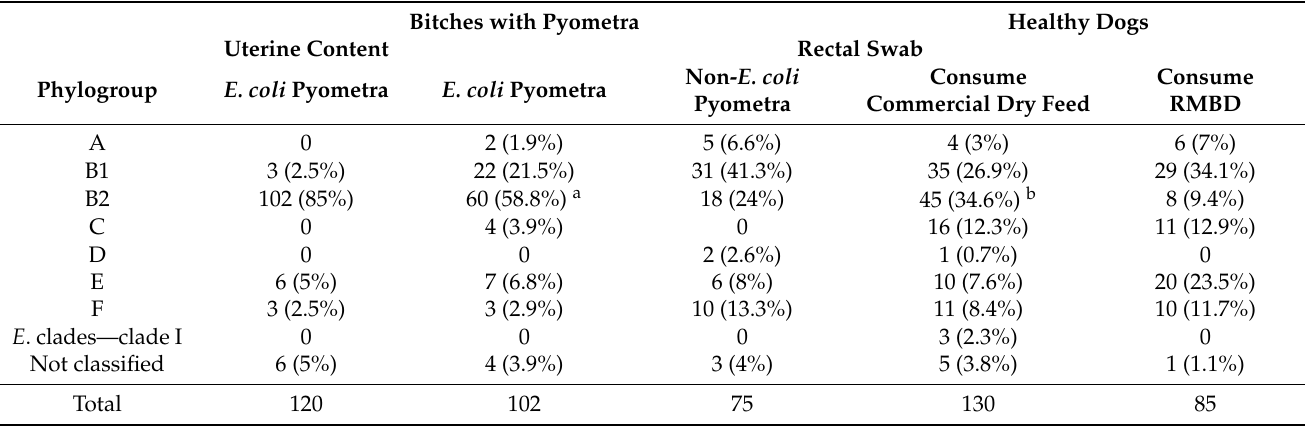
Table 2. Number of isolates and frequency of E. coli phylogroups identified in the uterine content, rectal swabs of bitches with pyometra and rectal swabs of healthy dogs. Bitches with Pyometra Healthy Dogs Uterine Content Rectal Swab Non- E. coli Consume Phylogroup E. coli Pyometra E. coli Pyometra Pyometra